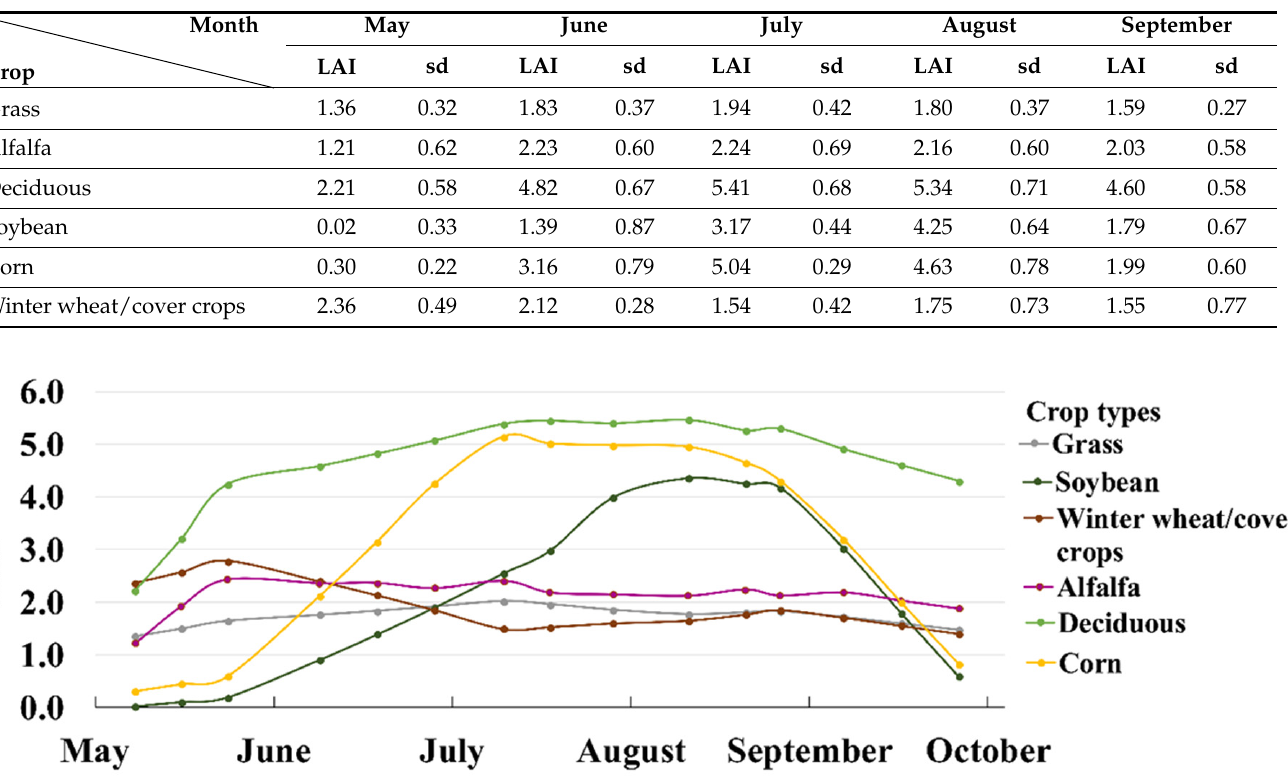
Figure 5. Estimated leaf area index (LAI) time series in 2018 over the watershed based on empirical equations.